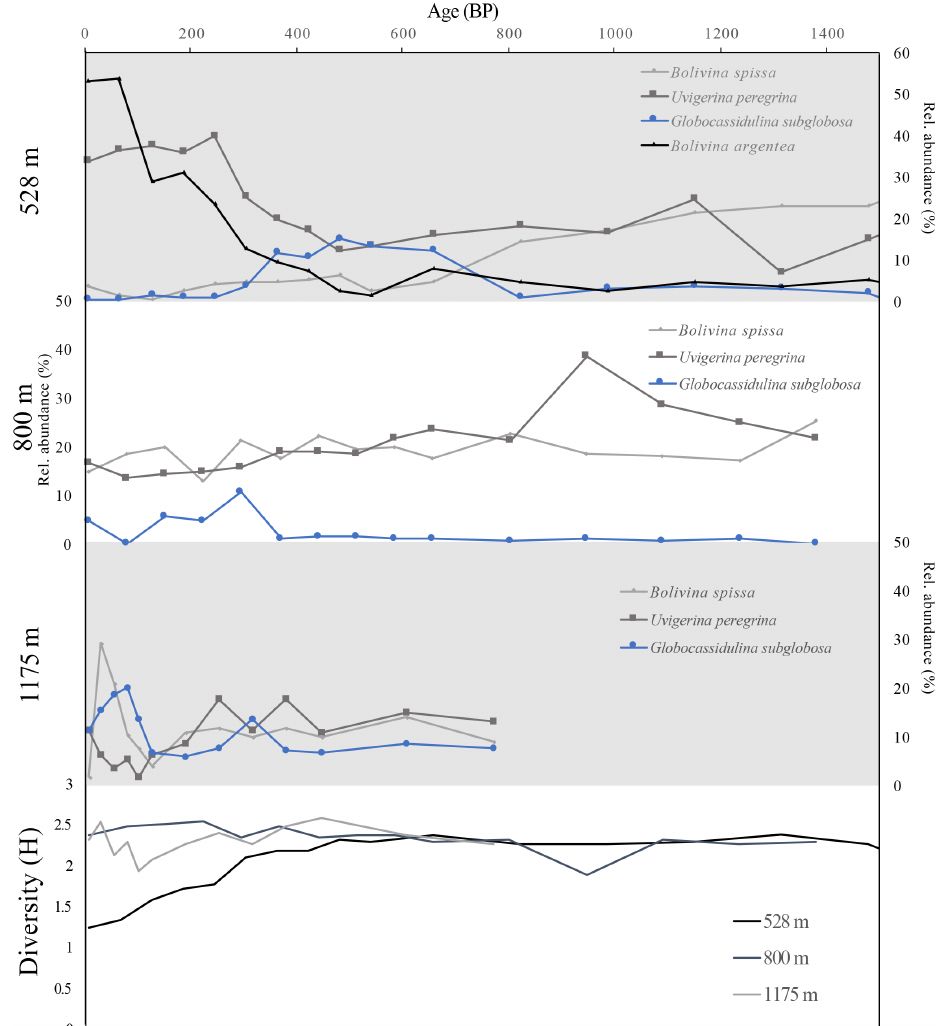
Figure 4. Top three panels show relative abundance of two species of hypoxia indicator foraminifera ( B. spissa and U. peregrina , gray lines) and one species of oxic indicator foraminifera ( G. subglobosa , blue lines) from the > 150µm size fraction down-core through time, in years before present for cores from three water depths (528, 800, 1175m). Top panel also includes relative abundance of B. argentea (edge associated). Bottom panel shows diversity (Shannon’s index, H ) through time for three